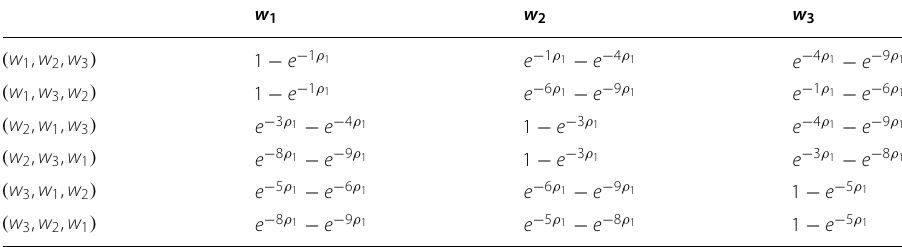
Table 4 Contributions